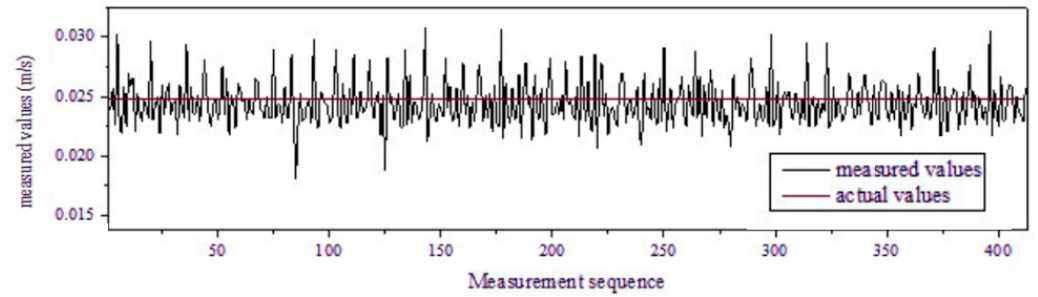
Figure 6. Measurement results of the indoor experiment.